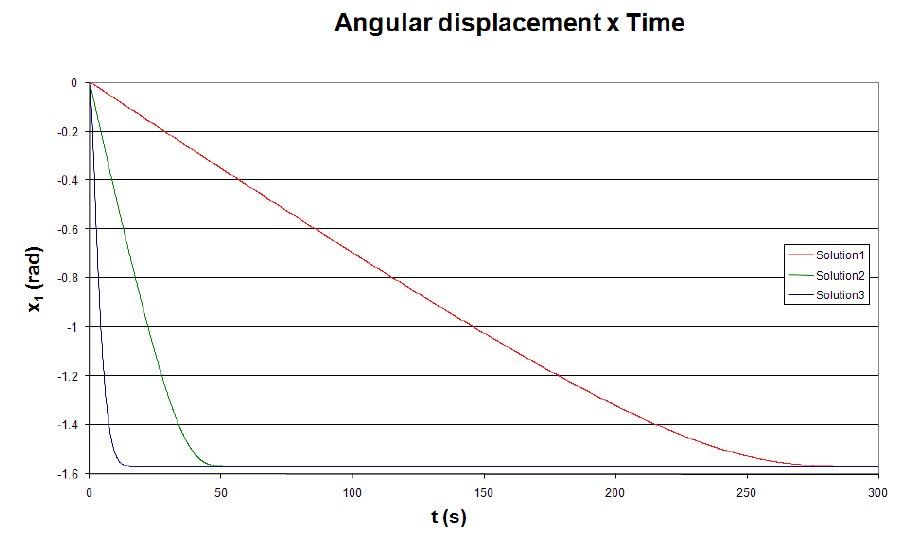
Fig. 4. Angular displacement for the three solutions 1, 2 and